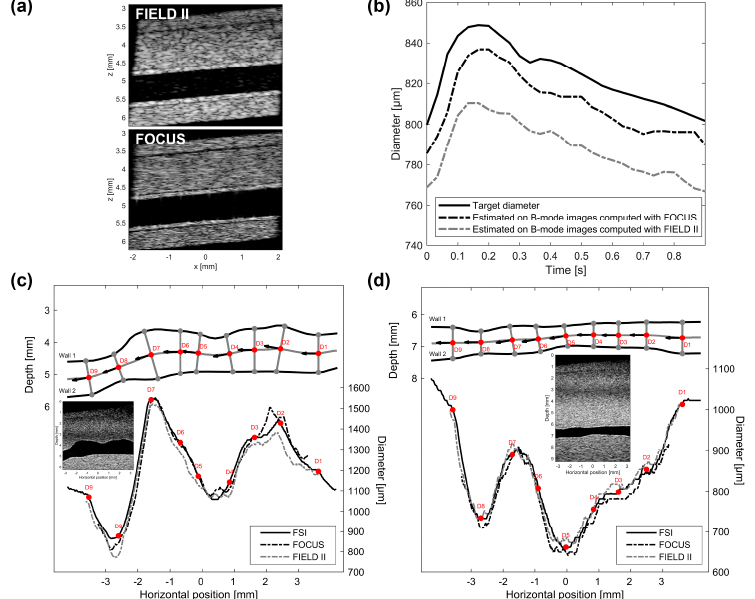
Figure 13. Diameter computation; ( a – b ) cylindrical artery: ( a ) B-mode images simulated with Field II and Focus; ( b ) comparison between the target and Field II/Focus diameters over a cardiac cycle; ( c , d ) comparison between the diameters computed with the fluid–structure Interaction (FSI) model and Field II/Focus for the true artery; ( c ) slice 1; ( d ) slice 2.